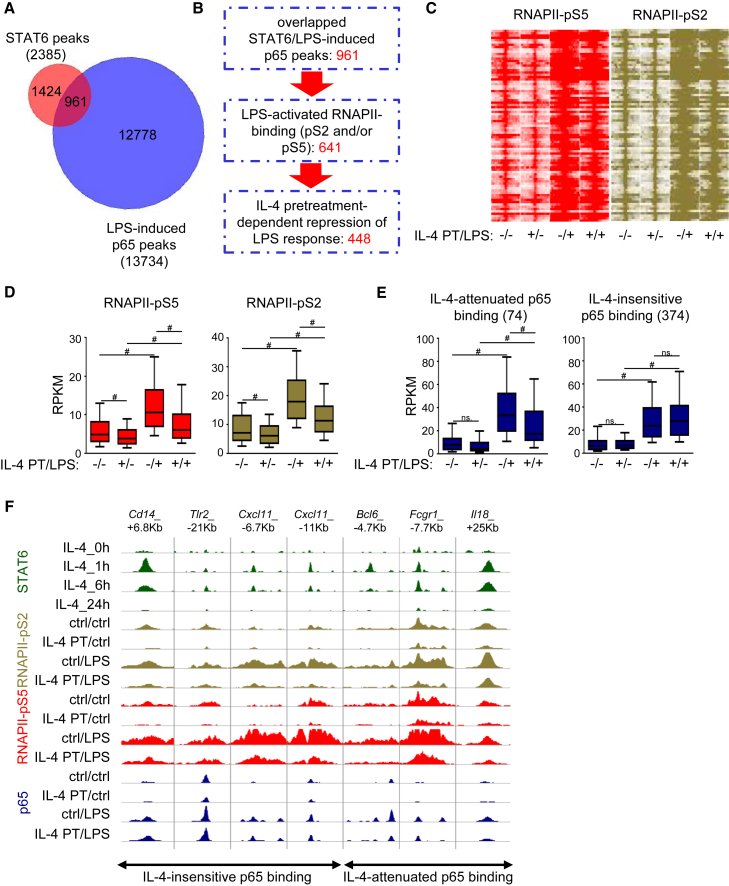
Attenuated Inflammatory Response Is Conferred by the Repressive Action of IL-4-STAT6 Signaling on a Subset of Enhancers(A) Venn diagram of the overlap between the STAT6-bound regulatory regions associated to IL-4-inhibited LPS-responsive genes and the LPS-activated p65 cistrome.(B) Flowchart of the identification of IL-4-repressed, LPS-inducible inflammatory enhancers. Significant changes in RNAPII binding were identified by DiffBind analysis (p ≤ 0.05).(C) Read distribution plot of ChIP-seq intensities for RNAPII-pS5 and RNAPII-pS2 around the summit of STAT6 peaks on the identified 448 overlapping STAT6 and p65-bound regulatory elements exhibiting IL-4-dependent attenuation of LPS response.(D) Boxplot of the average coverage (RPKM) for RNAPII-pS5 and RNAPII-pS2 binding at the regulatory regions presented on the read distribution plot on (C), exhibiting attenuated LPS response in IL-4-pretreated BMDMs. Boxes encompass the 25th to 75th percentile RPKMs. Whiskers extend to the 10th and 90th percentiles.(E) Boxplot of the average coverage (RPKM) for p65 binding at the regulatory regions presented on the read distribution plot on (C), exhibiting attenuated LPS response in IL-4-pretreated BMDMs. Regulatory regions showing repressed (left) and not influenced (right) p65 binding are shown. Boxes encompass the 25th to 75th percentile RPKMs. Whiskers extend to the 10th and 90th percentiles.(F) Genome browser views of the IL-4 repressed regulatory regions showing attenuated LPS response in IL-4-pretreated BMDMs. ChIP-seq signals for RNAPII-pS5, RNAPII-pS2, and p65 are shown.BMDMs were pretreated with IL-4 for 24 hr followed by 1 hr LPS exposure (A–E). Data (A–E) are combined from two independent biological replicates. Changes (D, E) were considered significant at p < 0.00001 using paired t test and an average fold change cut off value of ≥ 1.15 was used between control and IL-4-treated samples. # means significant difference, ns indicates not significant difference. Data (F) are representative of two independent biological replicates.